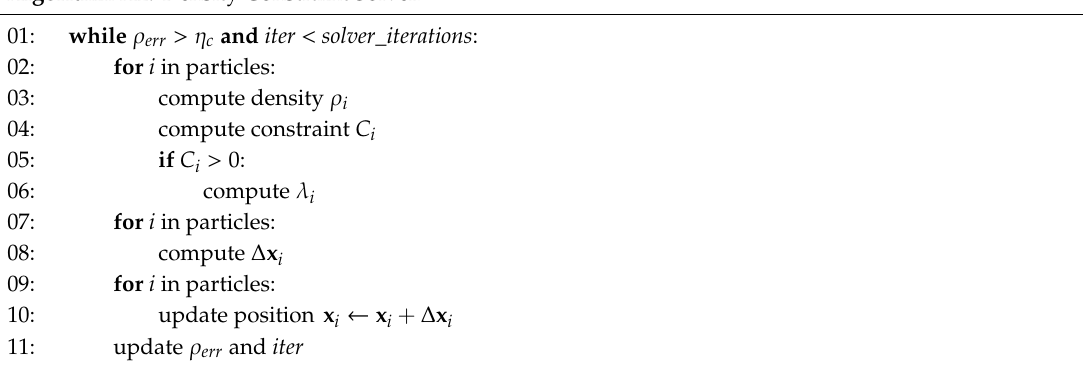
Algorithm A2. Density Constraint